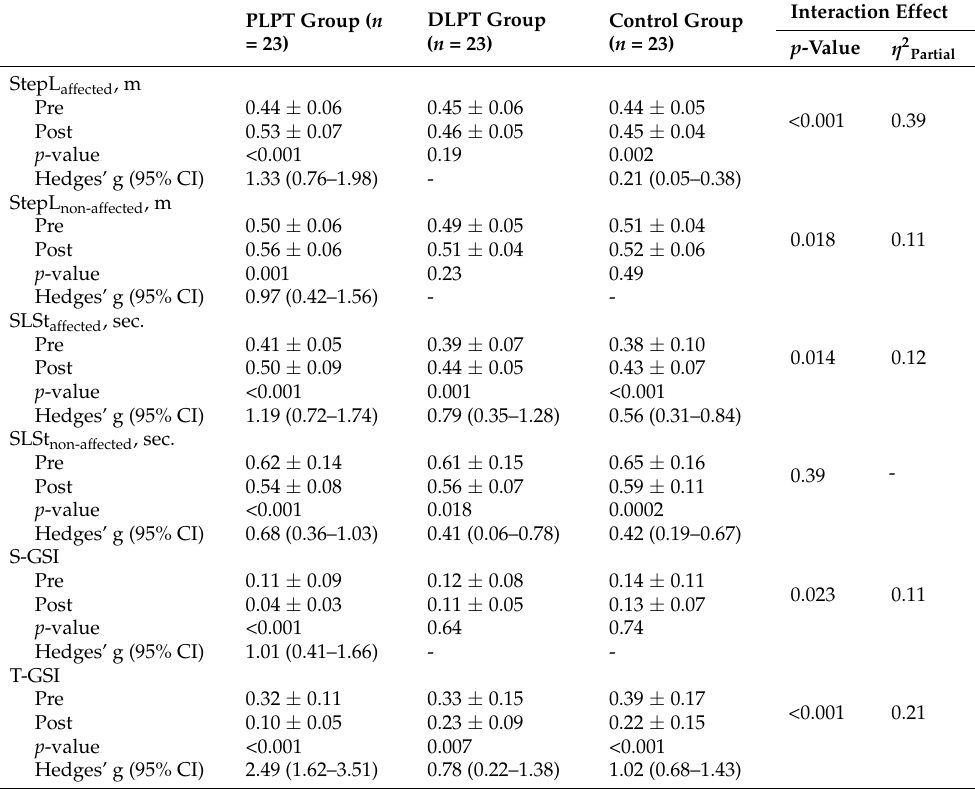
Table 4. Variations in gait symmetry outcomes between the study groups.